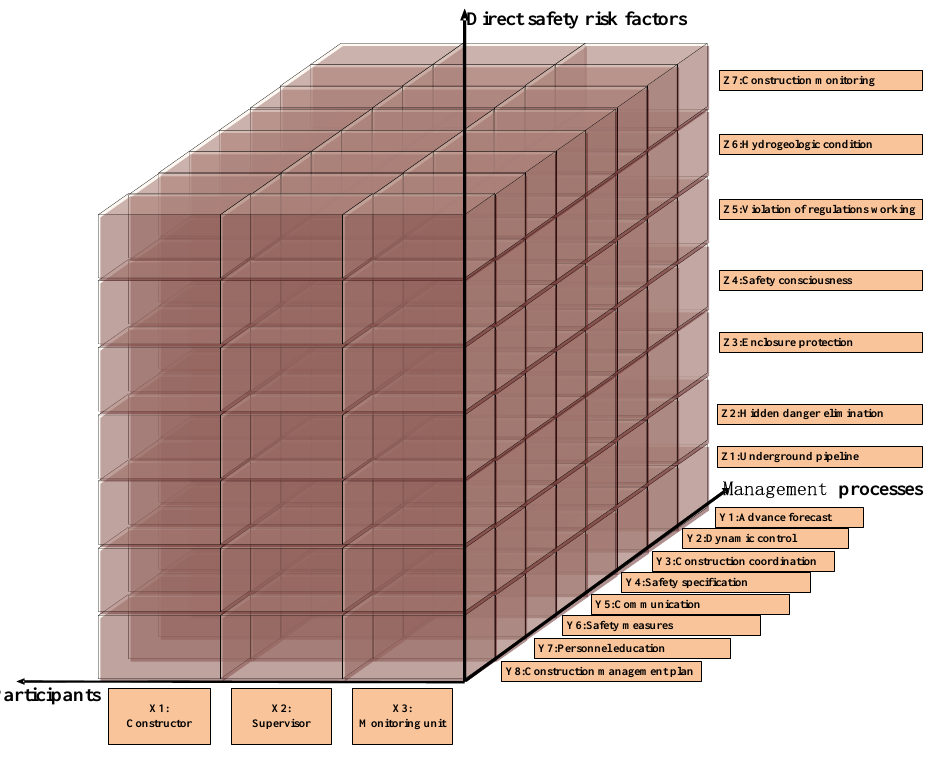
Figure 5. Accident descriptive model.